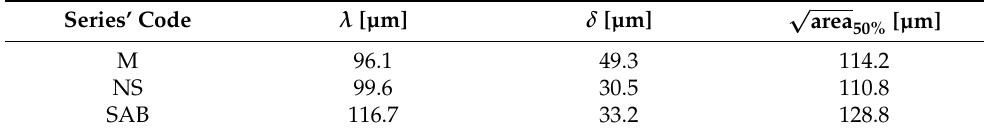
Table 3. LEVD distribution parameters for machined, net-shape and sandblasted